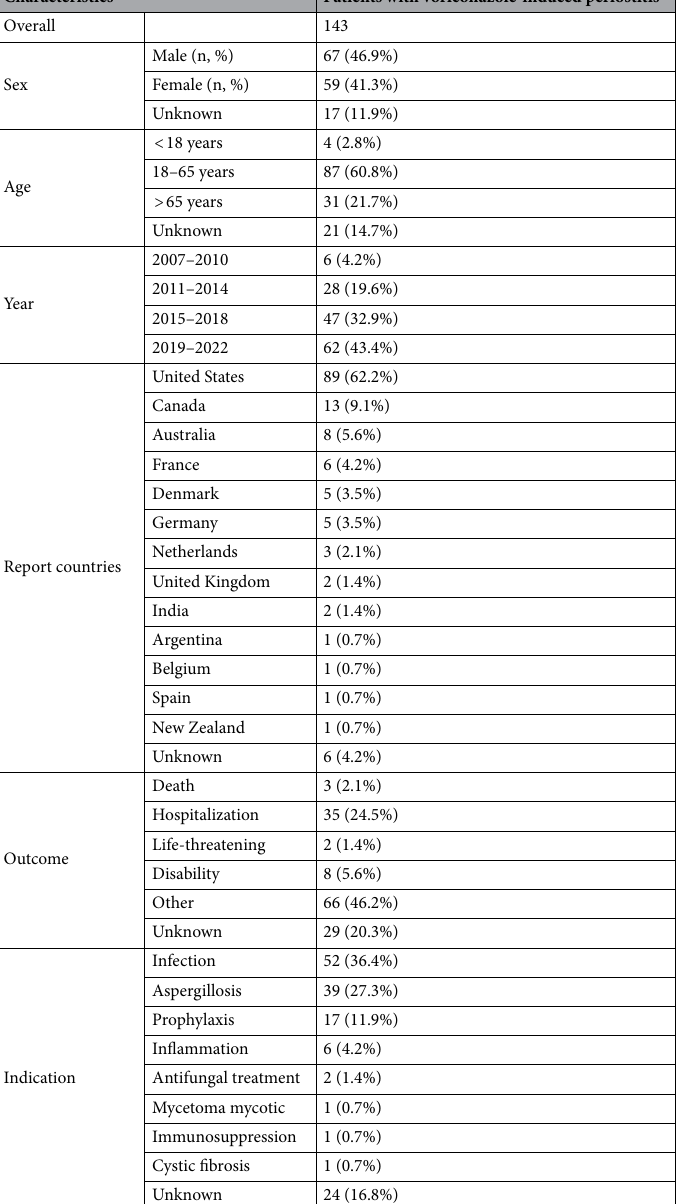
Table 1. Characteristics of patients with voriconazole-induced periostitis.